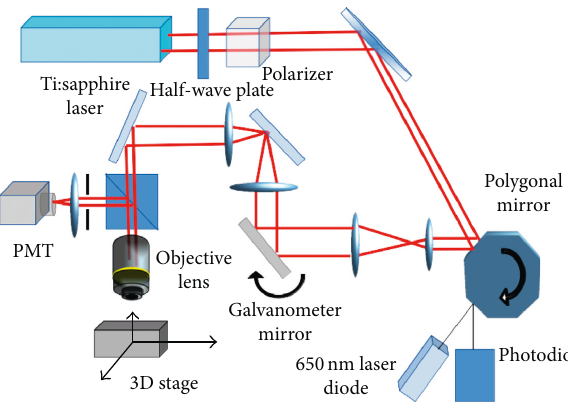
Figure 1: Experimental setup for second harmonic generation